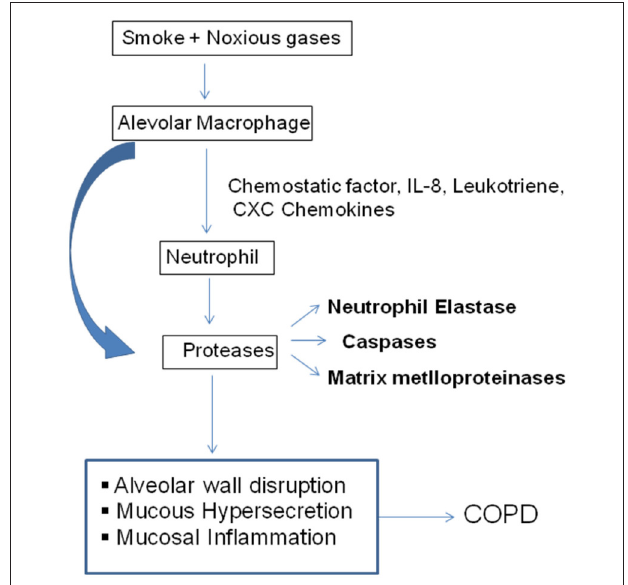
FIGURE 2 | Inflammatory mechanism in COPD. Cigarette smoke or other toxic particles activates the macrophage in the respiratory tract and release neutrophil chemotactic factors like IL-8, leukotrine, CXC chemokines. These cells further release proteases of different classes, which break down connective tissue in the lung parenchyma resulting COPD (Barnes,